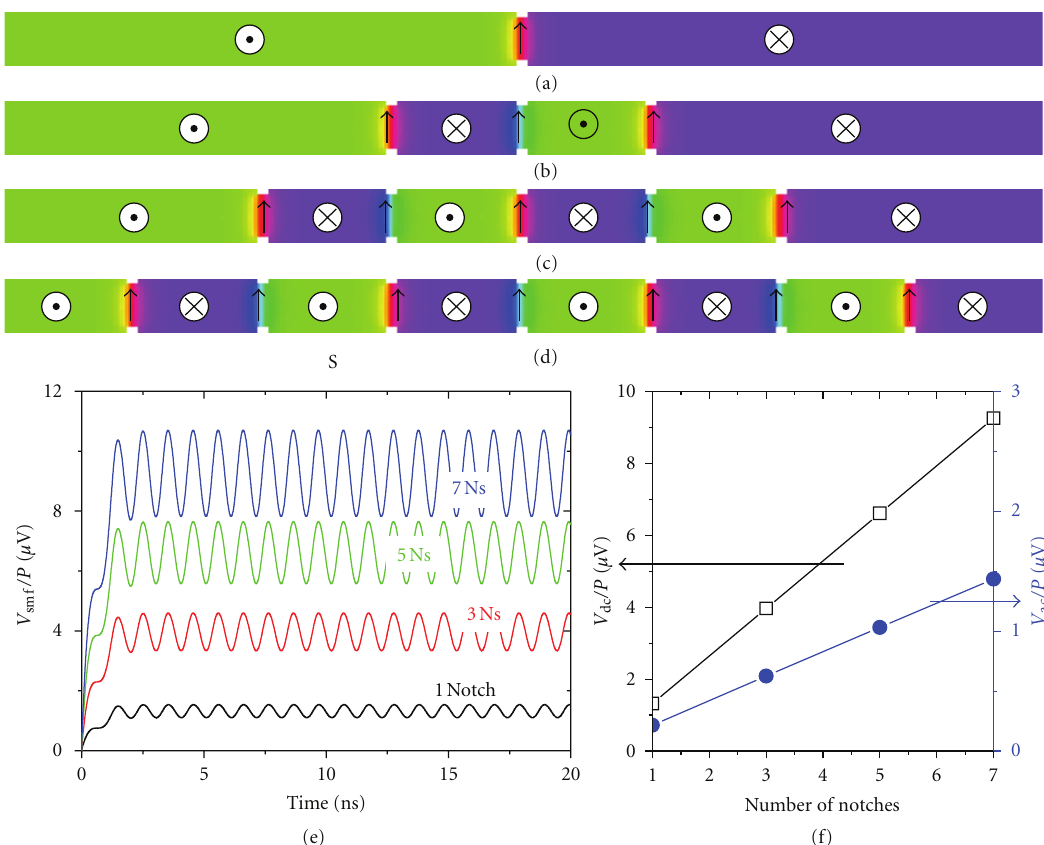
Figure 11: Equilibrium states with (a) one, (b) three, (c) five, and (d) seven Bloch DWs pinned at di ff erent notches separated each other by S = 138nm. (e) Voltage signal as a function of time for a strip with di ff erent number of pinned DWs. The applied current is j a = 0 . 05A /μ m 2 and the perfect adiabatic case was considered. (f) Static ( V dc ) and oscillating ( V ac ) contributions of the voltage signal V smf ( t ) as a function of the number of pinned DWs. (from